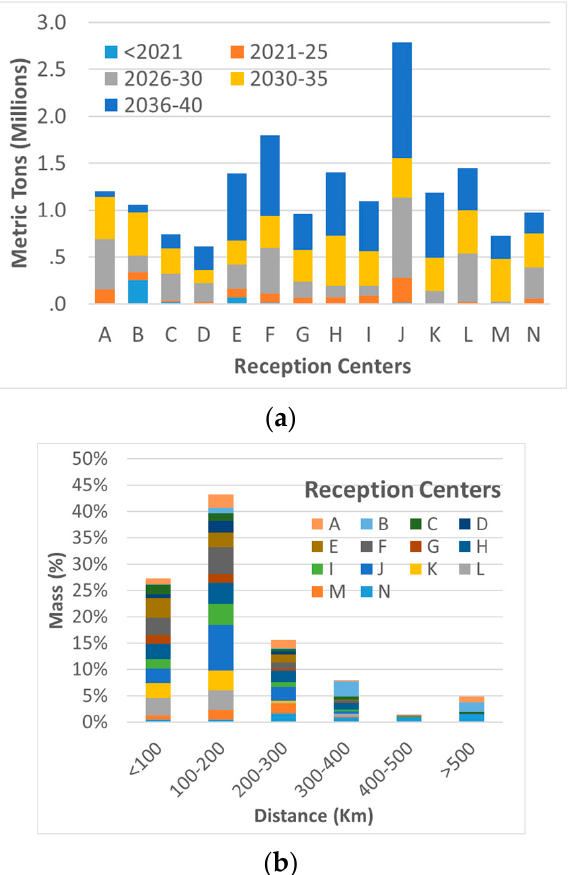
Figure 11. Spatiotemporal performance of US—EoL centers for decommissioned wind turbines ( a ) over time, considering decommissioning year from <2021 to 2040 and ( b ) distance.